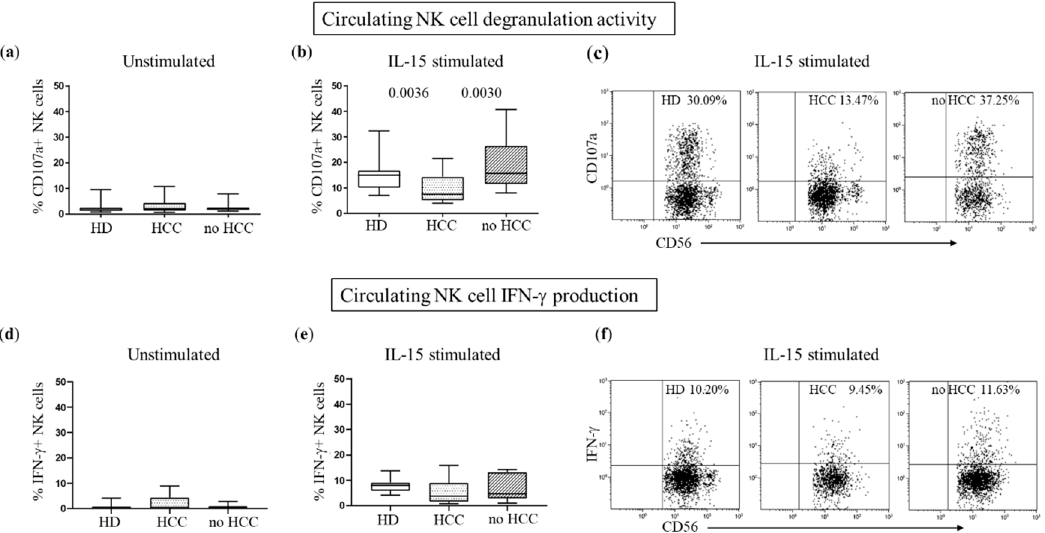
Figure 5. Decreased DNAM-1-mediated cytotoxicity in circulating NK cells. A reverse antibody- dependent cytotoxicity (rADCC) assay was used to test DNAM-1 receptor-mediated NK cell func- tions. Degranulation activity (%CD107a+ NK cells) of circulating NK cells from 11 HDs, 20 HCC subjects, and 11 no HCC subjects was analyzed before ( a ) and after ( b ) IL-15 stimulation. ( d , e ) IFN- γ production was tested in NK cells from 11 HD, 15 HCC subjects, and 11 no HCC subjects, under the same experimental conditions. Middle bars represent median values, box plots are 25% and 75% percentiles, whiskers are minimum and maximum values. The non-parametric Kruskal–Wallis test was used to compare data. Representative dot plots of degranulation ( c ) and IFN- γ production ( f ) of stimulated NK cells from HDs, HCC subjects, and no HCC subjects are also shown.